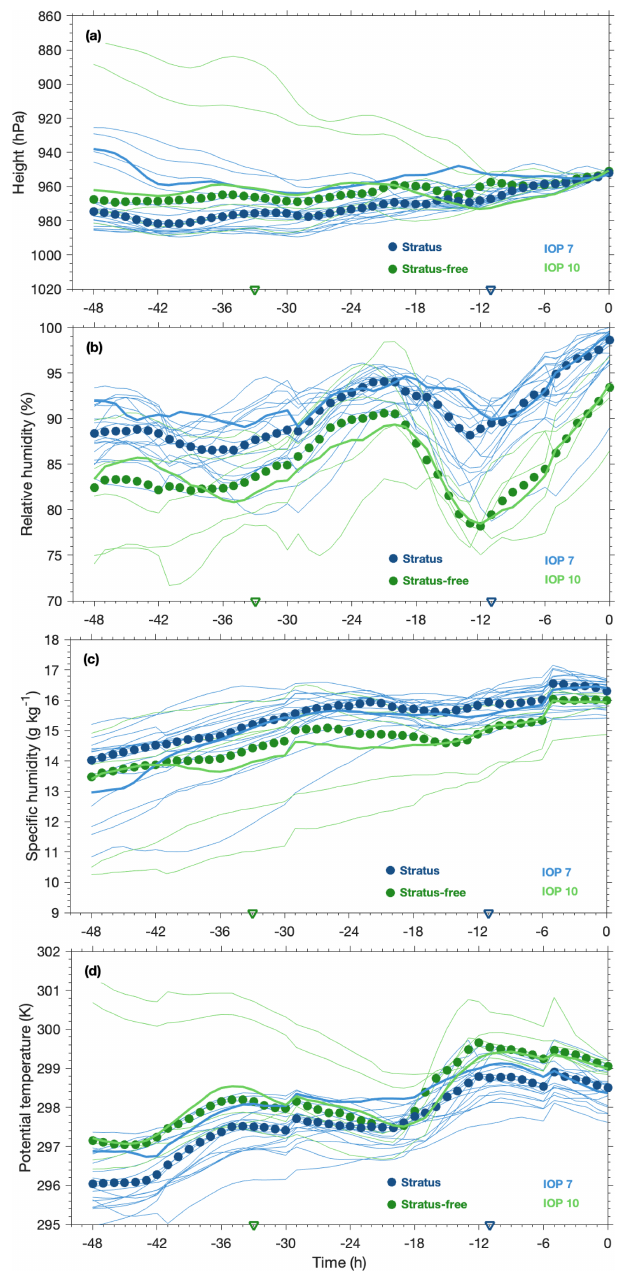
Figure 13. Temporal evolution of the median pressure (a) , rel- ative humidity (b) , specific humidity (c) and potential tempera- ture (d) along the trajectories averaged in the layer 30–50hPa (250– 416m) above the surface for stratus (blue circles) and stratus-free nights (green circles). The individual trajectories of each stratus and stratus-free night are shown in light blue and green, respectively. The thick blue and green lines indicate trajectories for IOP 7 and 10, respectively, while the blue and green triangles indicate the time when trajectories reach the land for IOP 7 and 10,